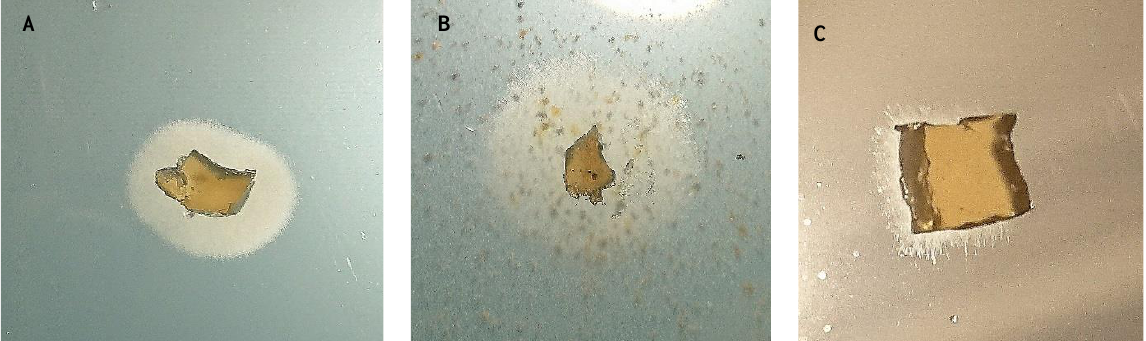
Fig. 3 Cultivation of S. indica on solidified broth culture supplemented with 0.1% eggshell extract ( A ), 0.1% eggshell powder ( B ) and eggshell pellet ( C ) at 25°C for 5 days